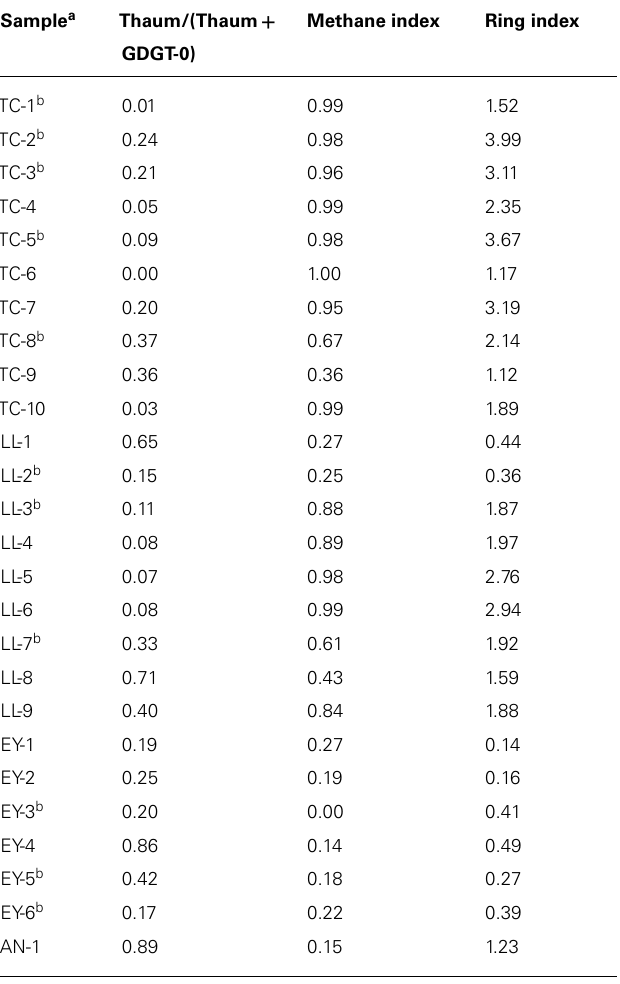
Table 3 | Proxies based on GDGTs fromYunnan hot